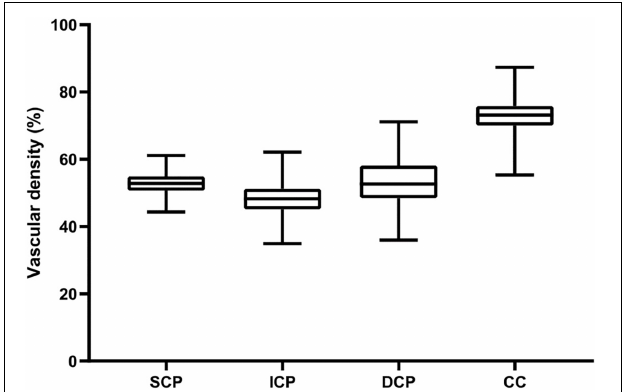
FIGURE 3 | Vascular density of the four retinal vascular plexuses in children. Box-plots show whole VD values within the SVP, DVC, ICP, and DCP, respectively. Vascular density (%) is represented on the y -axis. Upper and lower whiskers represent the upper and lower values. Upper and lower box margins represent the 25th and 75th percentiles. The white line inside the box is the median value. The VD is significantly different between each plexus (all P < 0.001), higher in the CC, followed by the DVP, the SCP, and the ICP.